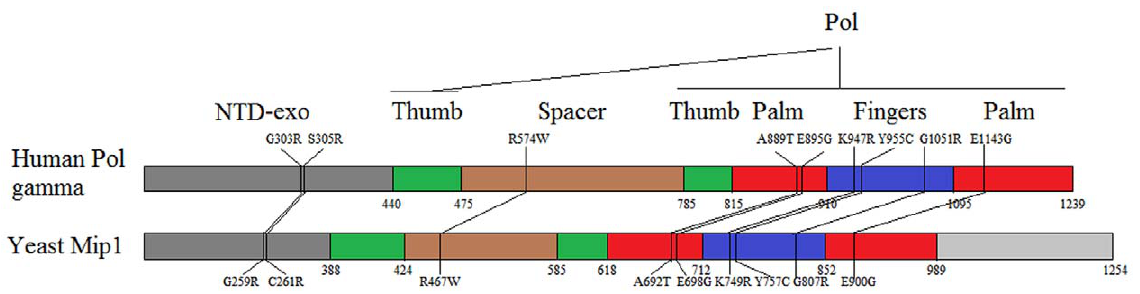
Figure 1. Linear representation of human Polg and yeast Mip1 with the mutations used in this study. NTD-Exo=N-terminal domain- 3 9 - 5 9 exonuclease domain. Pol=polymerase domain.